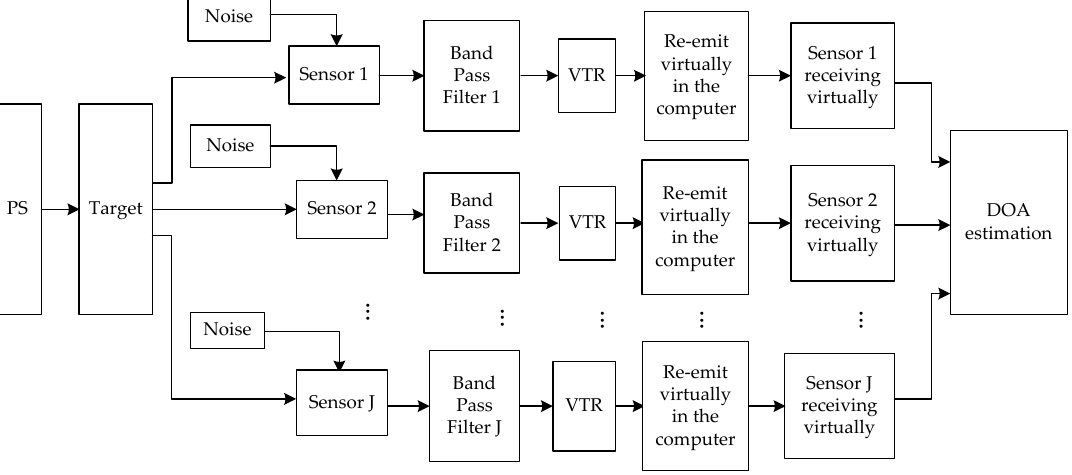
Figure 2. Flow diagram of the DOA estimation based on ADVTR.